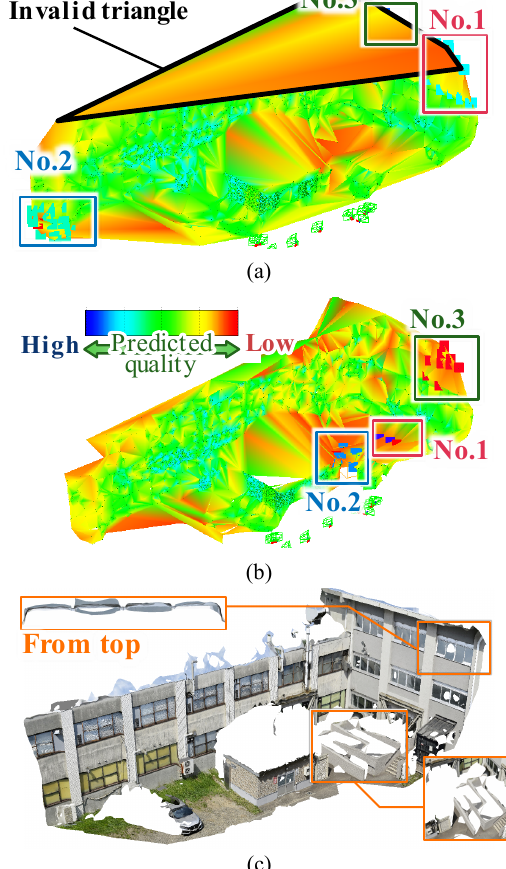
Figure 5. Approximated mesh models and the predicted qualities and final dense model of a building wall. (a)Approximated mesh model by our previous method (Moritani, 2019), and (b) by the proposed 𝑀𝑀 method. The color maps show the distributions of the ′ 𝑀𝑀 estimated geometry degradation indicator values, where red indicates low quality and blue indicates high quality. “No.1, 2, and 3” show three lowest- quality regions. (c) Final dense model with some low- quality regions (holes) generated by